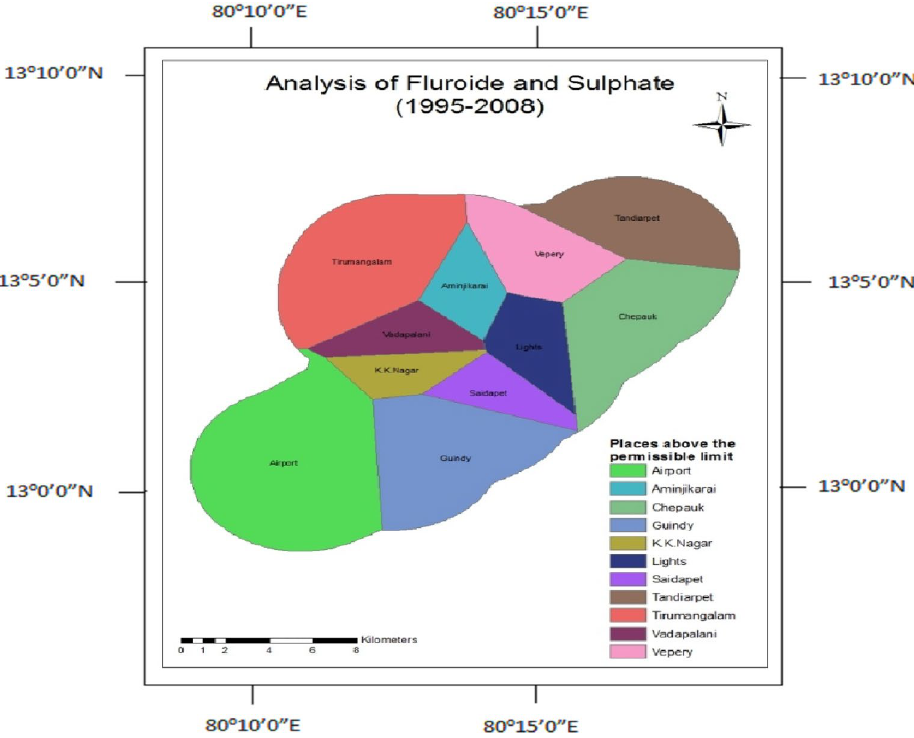
Figure 17. Analysis of fluoride and sulphate for 1995–2008.